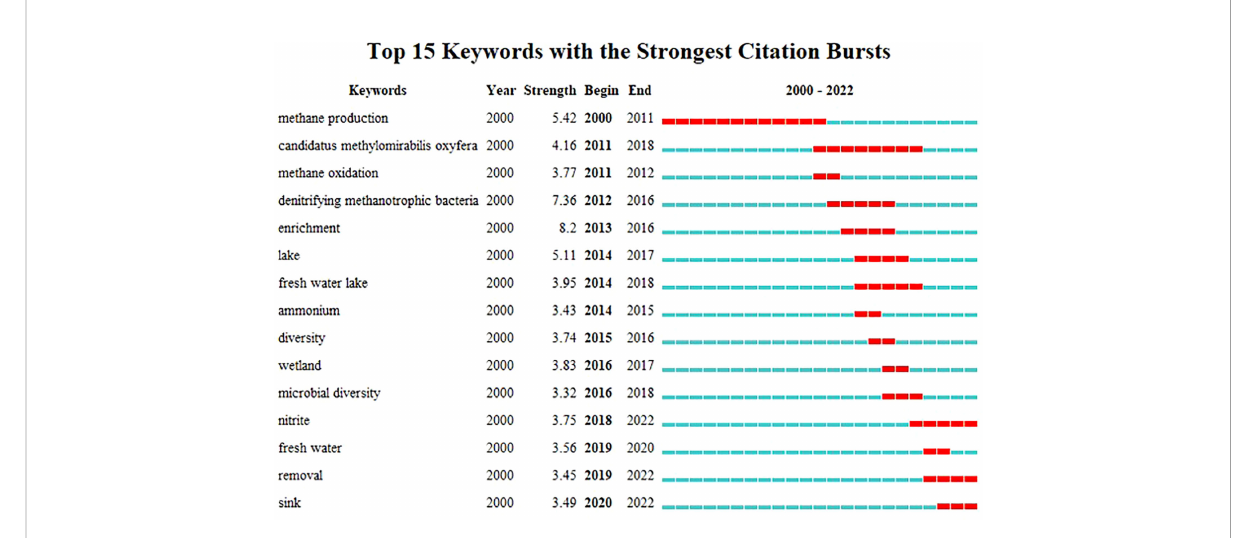
FIGURE 4 Keywords with strong citation bursts from 2000 –